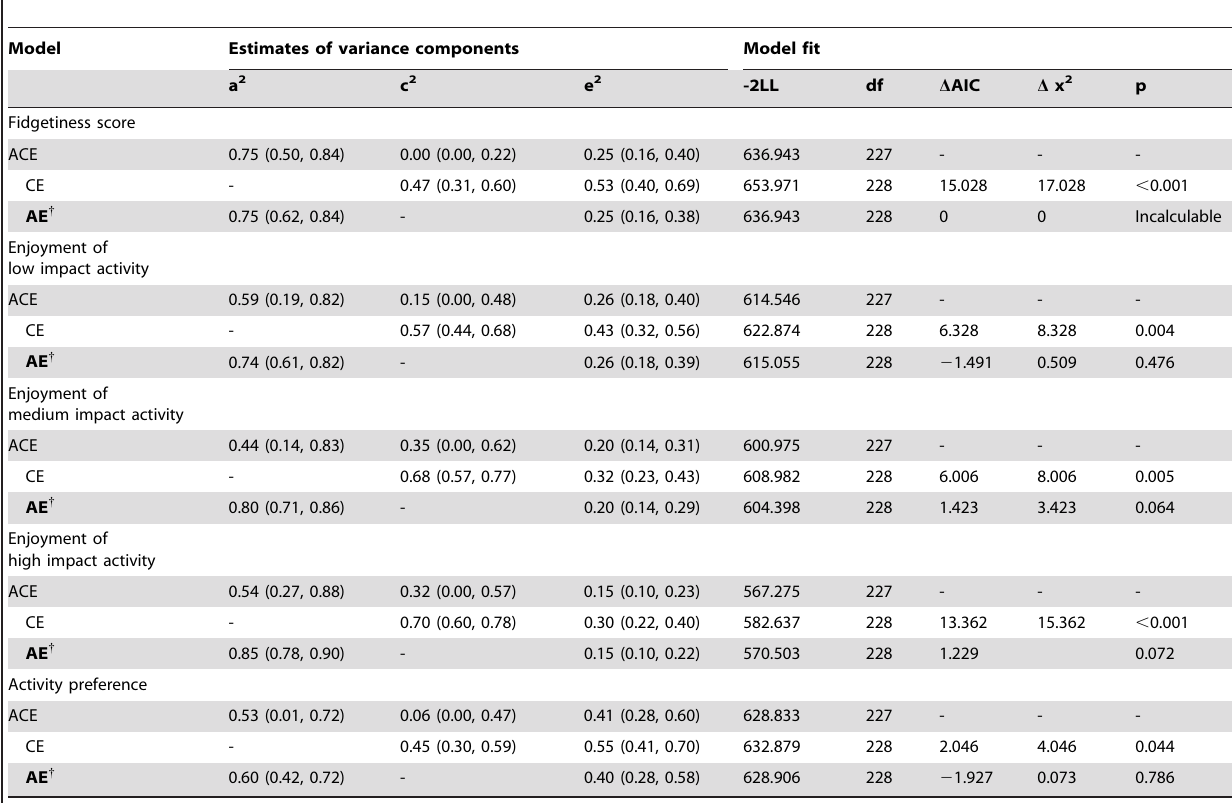
Table 3. Genetic and environmental influences on fidgetiness, enjoyment of activity and child reported activity preferences in 9– 12 year old twins.